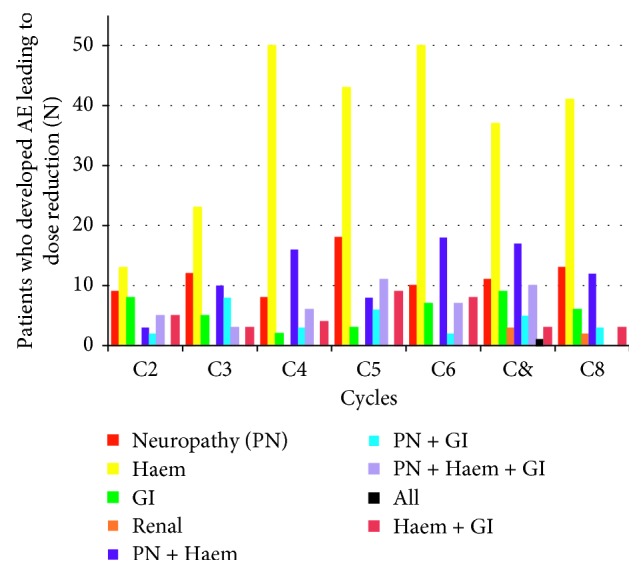
Documented causes for chemotherapy dose reduction and the number of patients who needed dose reduction in each cycle. aE: adverse events; Haem: haematological; GI: gastrointestinal. These data are only for the patients where the cause for dose reduction was clearly reported. There were a large number of cases where the reasons for dose reduction were not reported.